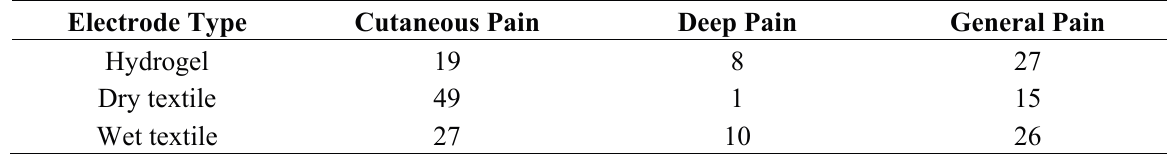
Figure 8. The sums of TESCQ scores of cutaneous, deep and general categories with the three different electrode types from all the subjects. Table 4. Sum of TESCQ scores for different types of electrode from all the subjects.